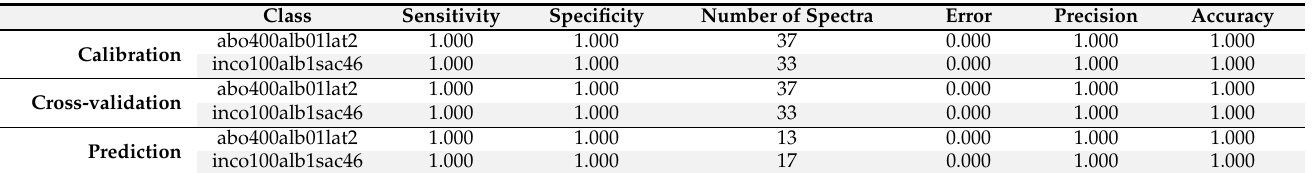
Table 4. Performance metrics for PLS-DA of incobotulinum A toxin (inco100alb1sac46) and abobotulinum A toxin (abo400alb01lat2), using the wavelength ranges selected by the VIP scores method: